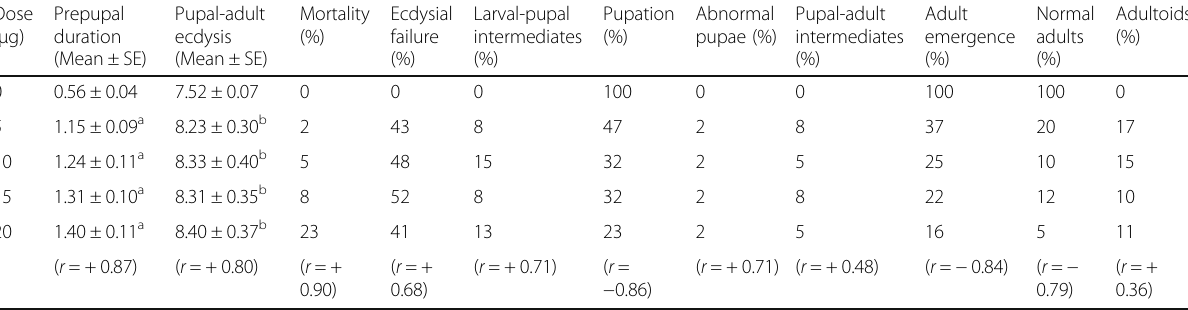
Table 1 Topical administration of seed extracts of Withania somnifera on prepupal stage of Spodoptera litura ( n = 20; replicate = 3) Dose Prepupal ( μ g) duration (Mean ±